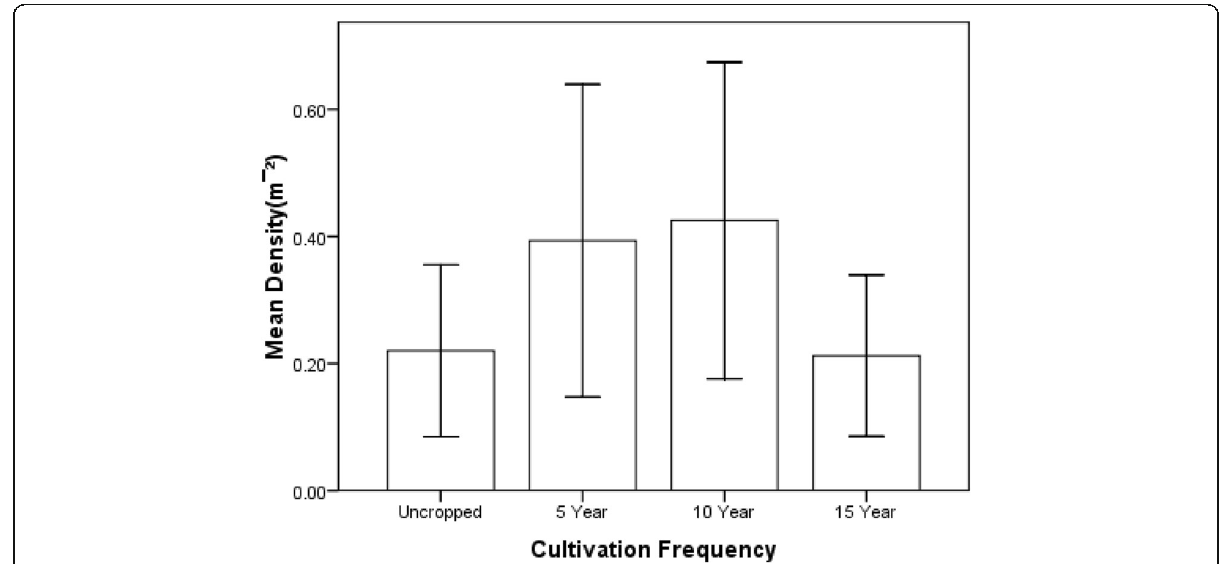
Fig. 4 Mean species density across the cultivation frequencies. There was no significant difference ( p >